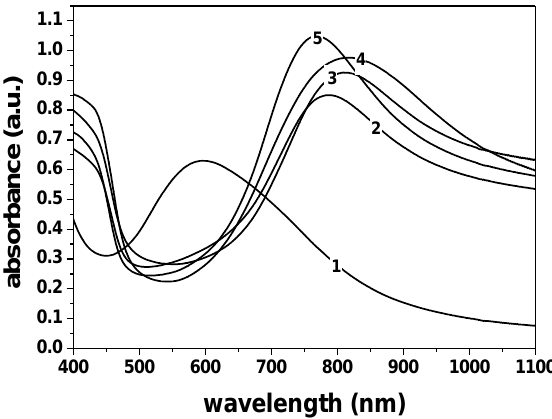
Figure 3. UV/Vis absorption spectra of thin films of PANI (1) dedoped in NH solution (EB) and of thin film of polyaniline emeraldine salt doped with various acids: (2) CSA, (3) TSA, (4) HCl and (5) MSA, on